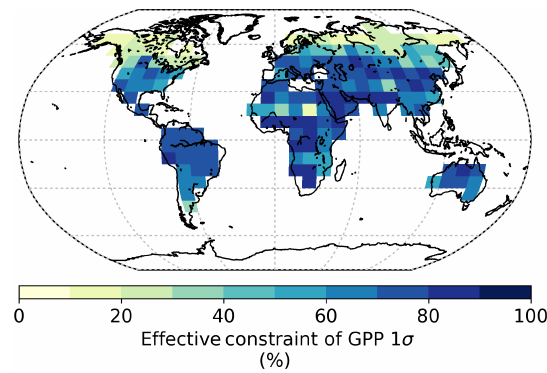
Figure 3. Annual observational uncertainty in SIF interpolated from GOSAT observations for 2010.